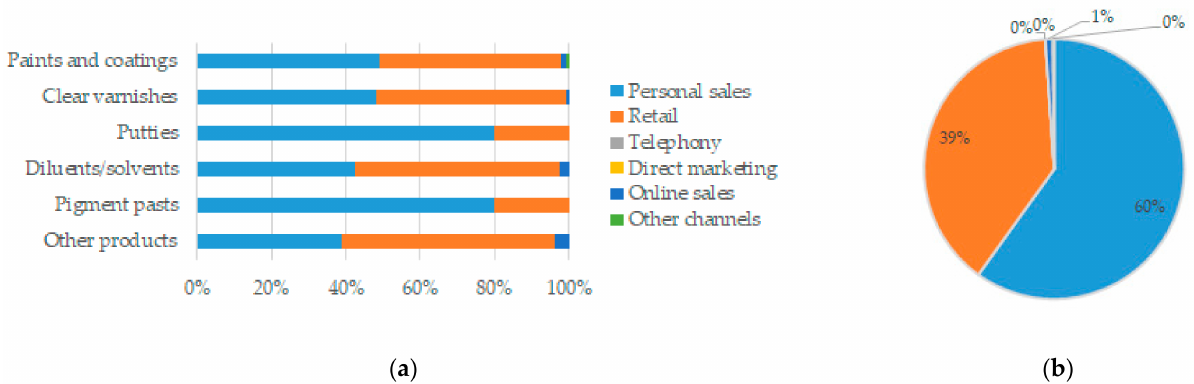
Figure 2. Sales of products to end customers (B2C): ( a ) Sales percentage of each product category by individual sales channel. ( b ) The total percentage of sales by individual sales channel.